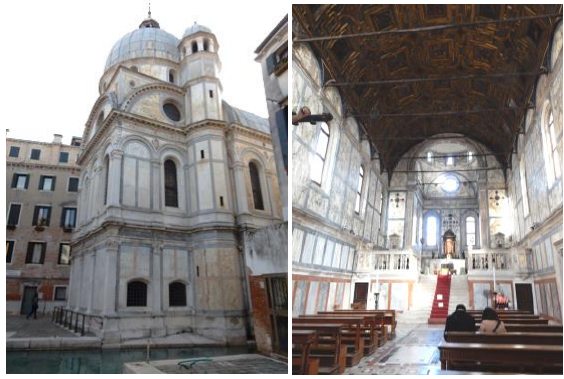
Figure 2. Santa Maria dei Miracoli church with the marble